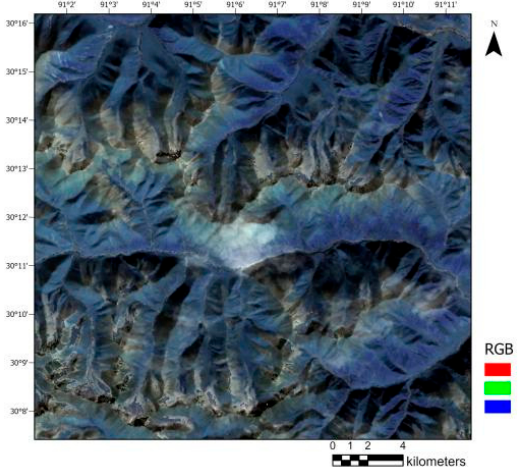
Figure 5. Spectral information of the band after iron-staining enhancement.